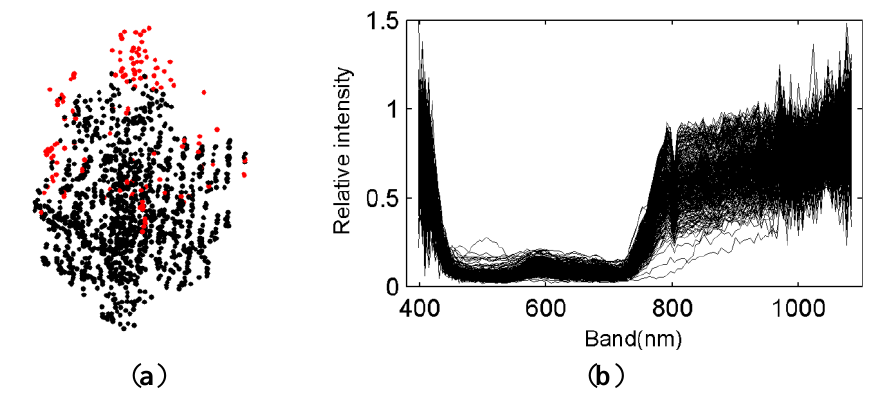
Figure 5. Illustrations of the spatial distributions of VIs (Red: VIs out of normal ranges) ( a ) and the spectra of the RP parts after processing for the same tree ( b ) as in Figure